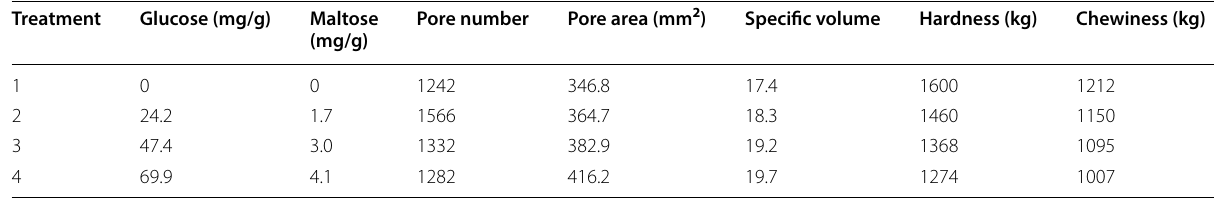
Table 4 Effect of glucose and maltose on the properties of CSB